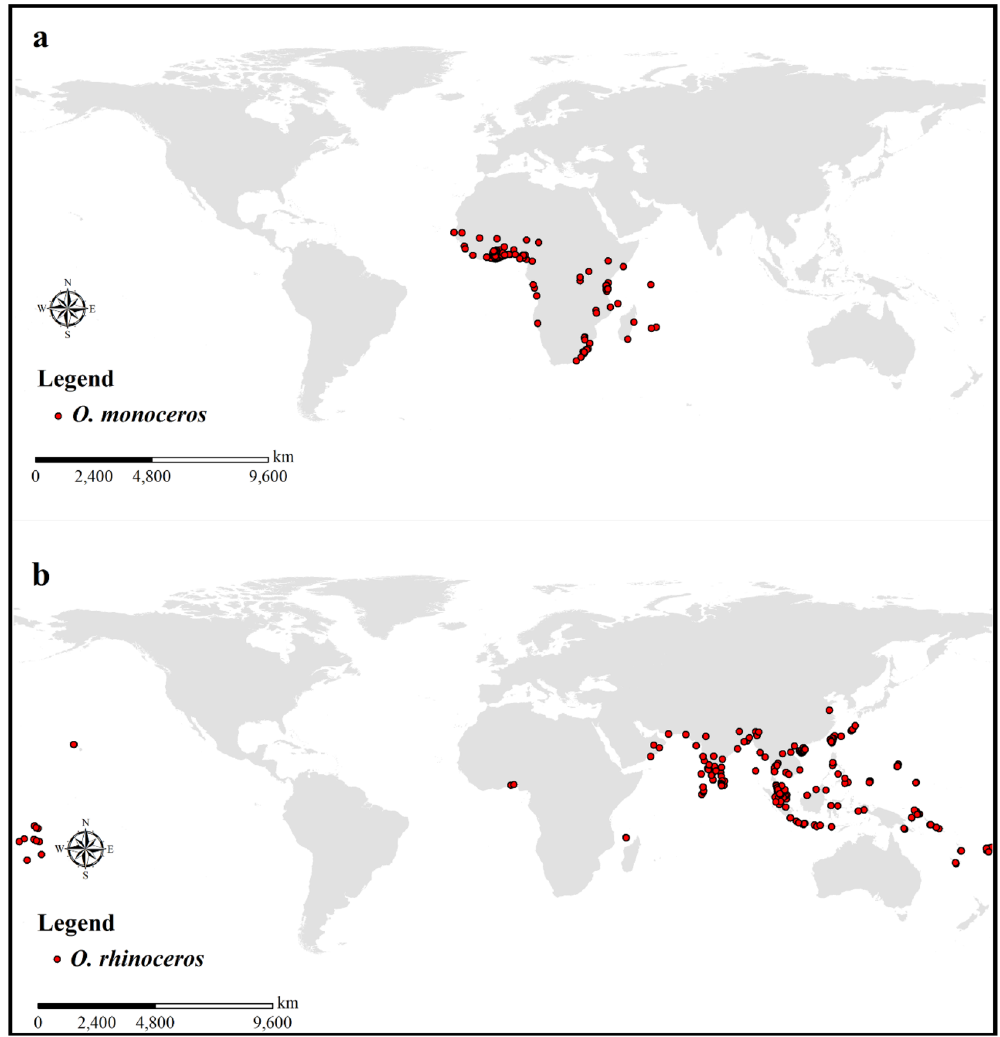
Figure 2. Occurrence records of O. monoceros and O. rhinoceros. ESRI ArcMap 10.2.2 (https:// suppo rt. esri. com/ en/ Produ cts/ Deskt op/ arcgis- deskt op/ arcmap/ 10-2- 2# downl